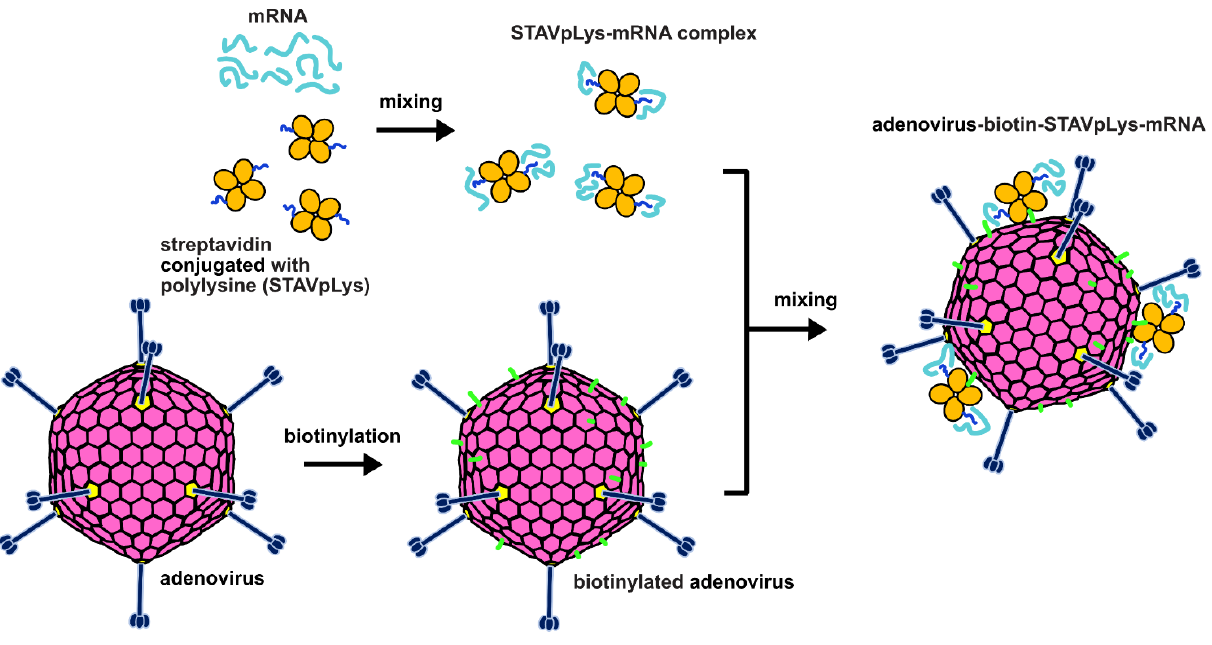
Figure 1. Schematic illustration of a novel chimeric nanosystem for mRNA delivery. In this study, we employed a straight-forward three step approach to prepare AdpL-mRNA complexes. Anionic mRNA is first mixed with cationic streptavidin tagged polylysine to form complexes capable of binding with biotin. In parallel, the adenovirus is biotinylated via chemical labelling of accessible amine groups using the EZ-Link kit. Lastly, the complexed STAVpLys-mRNA is conjugated to the biotinylated virus via simple mixing. This strategy allows for rapid generation of a functional mRNA vector using a pre-prepared adenovirus.